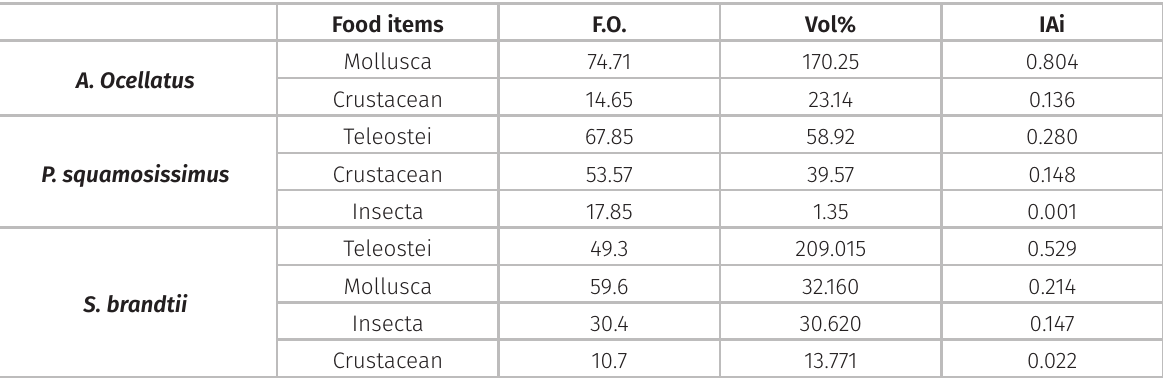
Table II. List of food items found in the stomachs of A. Ocellatus, P. squamosissimus , and S. brandtii captured in the Moxotó Reservoir. Frequency of occurrence (F.O.); Volume (Vol%); Food importance index (IAi = Fi x Vi / Σ (Fi x Vi), where: IAi= Importance index of item “i” in the diet of the sample; “Fi” = Frequency of Occurrence of item “i” in the sample; and “Vi” - Volumetric Analysis Index of the food item “i” in the sample. Food items